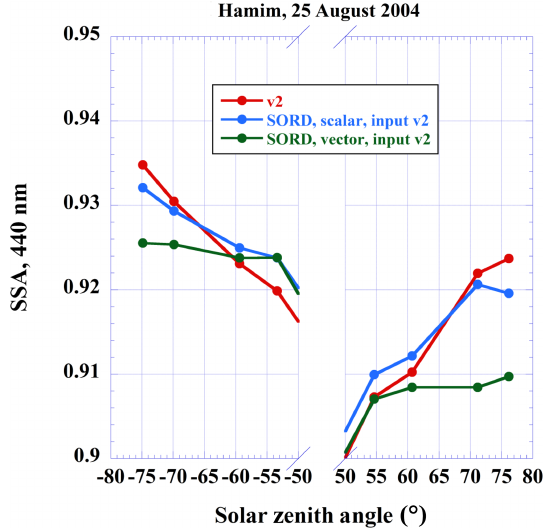
Figure 8. Hamim on 25 August 2004. The diurnal variability of Level 2 SSA retrievals at 440nm for three combinations of SORD and inversion inputs: V2 (red), SORD scalar mode (blue), and SORD vector mode using V2 inputs